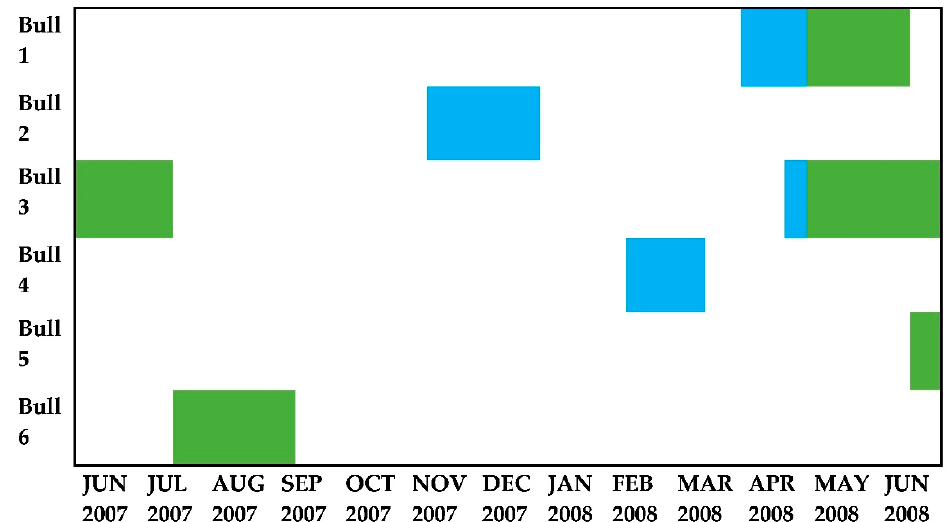
Figure 2. The time and duration each elephant bull experienced musth during the study. Green bars indicate periods of musth in the dry season, whilst blue bars indicate musth during the wet season.